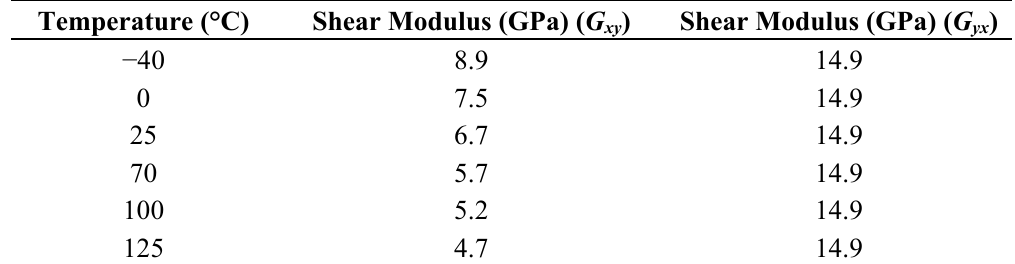
Figure 4. Temperature-dependent shear stress-strain curves and extraction of shear modulus of in-plane equivalent material for microbump unit with WLUF: ( a ) G xy ; ( b ) G yx . Table 3. Equivalent shear modulus of a microbump unit along the horizontal